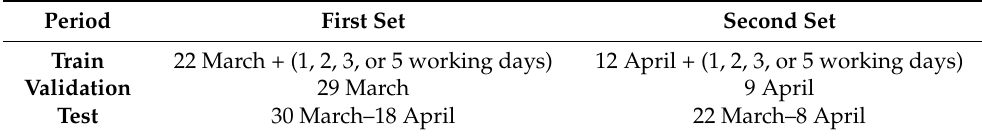
Table 2. The selected dates for training, validation and testing set. First Set